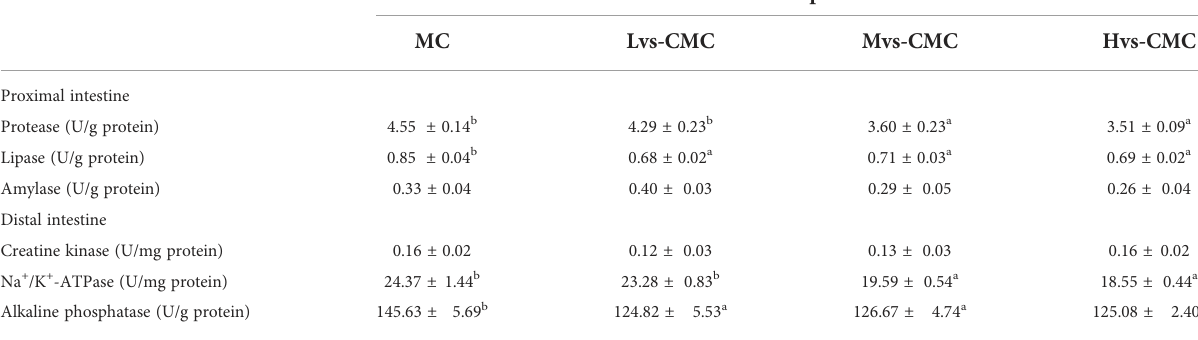
Values shown are the mean ± SEM (n = 4). Different superscript letters in the same row indicate signi fi cant difference between data (p < 0.05). MC, microcrystalline cellulose; Lvs-CMC, low-viscosity carboxymethyl cellulose; Mvs-CMC, medium-viscosity CMC; Hvs-CMC, high-viscosity CMC.